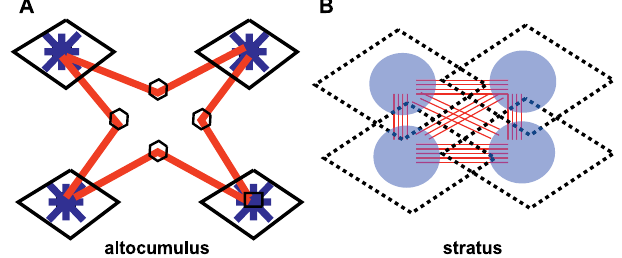
Figure 6. Modularity Paradigms Two representations of protein interaction network topology are shown. (A) Conventional view of functional modularity in which hub-centric modules are sparsely interconnected, i.e., a modular physical topology underlies functional modules [16,17]. (B) An integrated view in which functional modules are heavily interconnected, as supported by the large-scale organization of dense